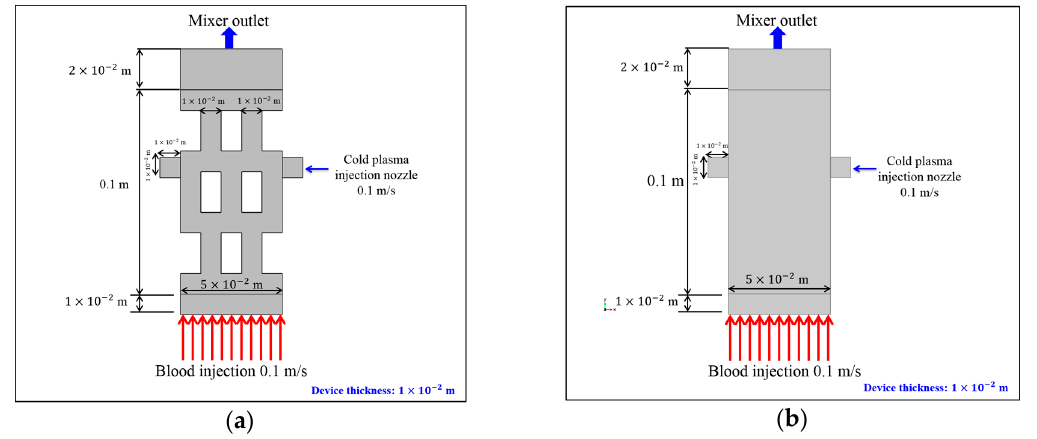
Figure 1. Mixing chambers ( a ) with and ( b ) without obstacles, with inlets and outlets shown.